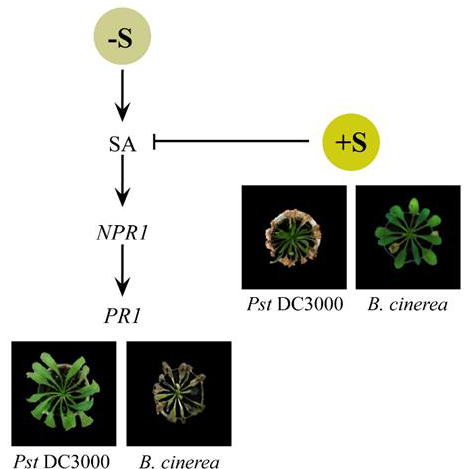
Figure 7. A schematic model is integrating the effect of sulfur on innate plant immunity mechanisms against Pseudomonas syringae pv. DC3000 (Pst DC3000) and Botrytis cinerea using Arabidopsis thaliana as a